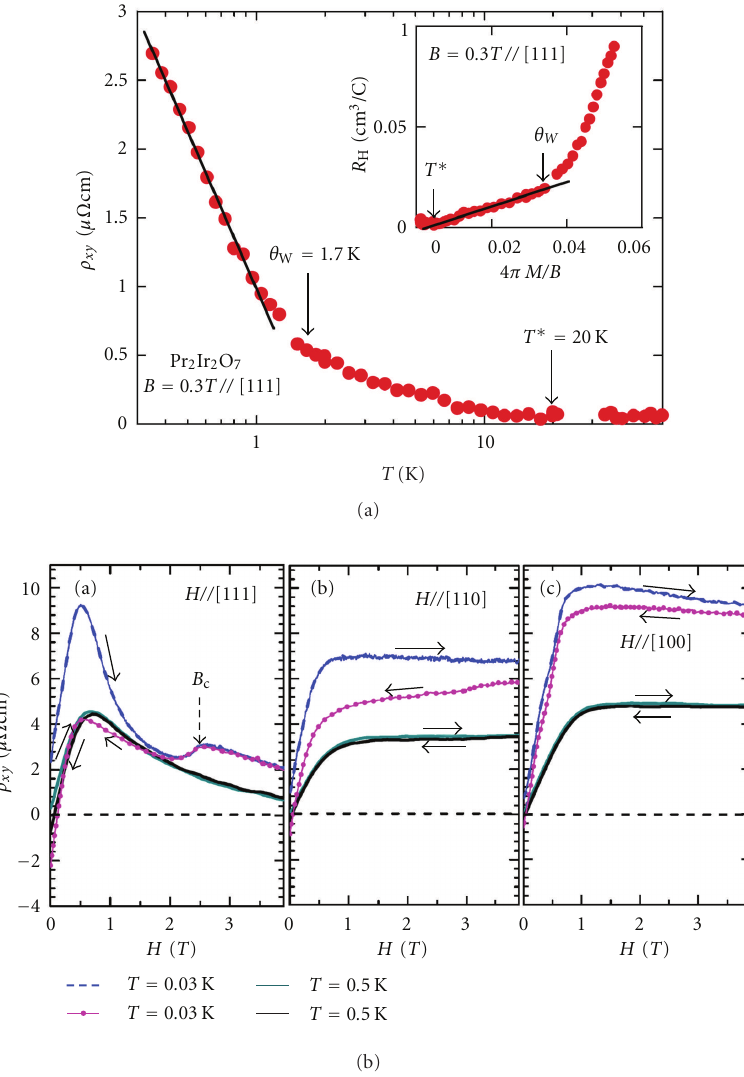
Figure 8: (a) A plot of anomalous Hall resistivity, ρ xy , against T , measured in a field of 0.3 T along the [111] direction of Pr 2 Ir 2 O 7 single crystals. A clear increase is seen below T ∗ = 20K before exponential growth below the Weiss temperature, | θ W | = 1 . 7K. The inset shows the reverse behaviour for the ordinary Hall coe ffi cient, R H , under the same conditions. The figure is taken from [9]. (b) Field-dependence of the anomalous Hall resistivity, ρ xy , with the field applied along the (a) [111], (b) [110], and (c) [100] directions of Pr 2 Ir 2 O 7 single crystals. The pronounced hysteresis along the [111] direction, suggested to host the “3-in, 1-out” spin structure, is severely reduced along [110] and [100] due to the stabilisation of the “2-in, 2-out” structure. Figure from